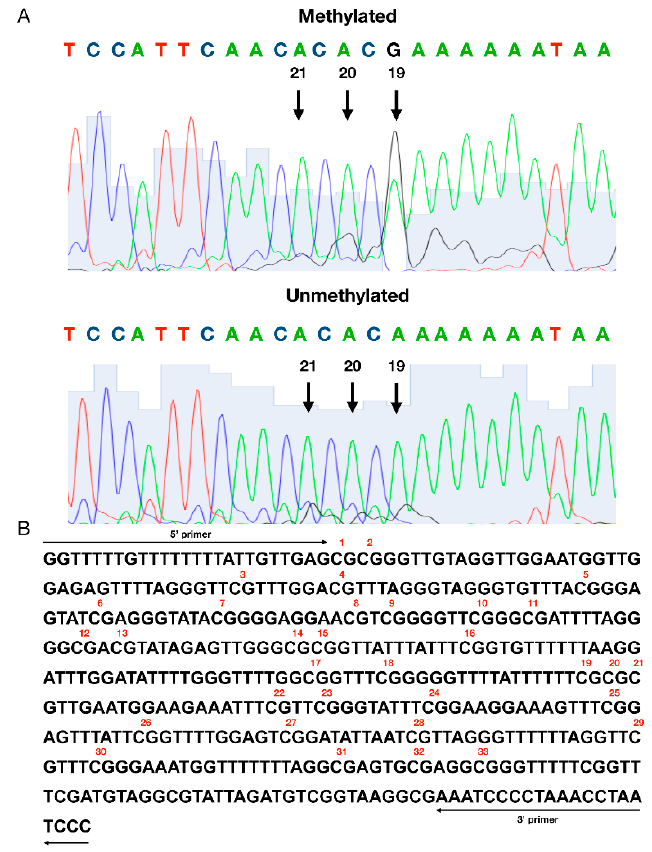
Figure 1. An assessment of a methylation status of individual CpG sites in the DAT1 promoter. ( A ) The representative result of the positive (top) and negative (bottom) methylation statuses; ( B ) the sequence of the analyzed DAT1 promoter. Numbers were assigned to individual sites in the studied region starting from 5 ′ . The methylation status of individual CpG sites was detected with a cut-off level at 20% of the G/A + G ratio using 4Peaks software (Mek & Tosj, Amsterdam, The Netherlands).